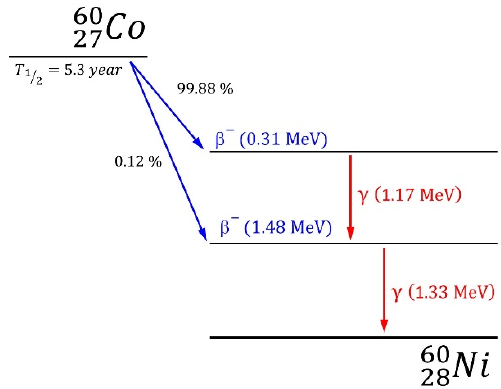
Figure 4. Decay scheme of 60 Co.